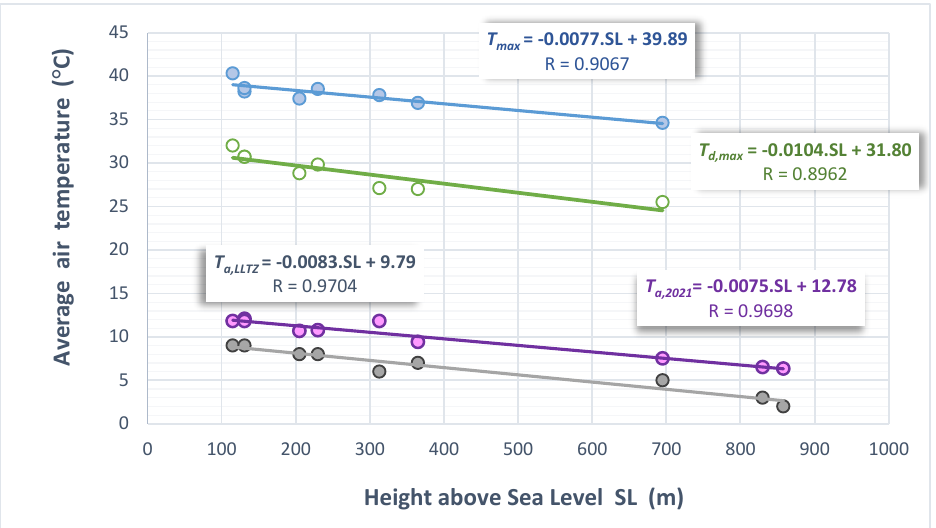
Figure 11. Linear correlation dependences of the air temperatures L max , L d, max , L a,2021 , and L a, LLTZ on the SL of CCP found from 1971 to 2017.